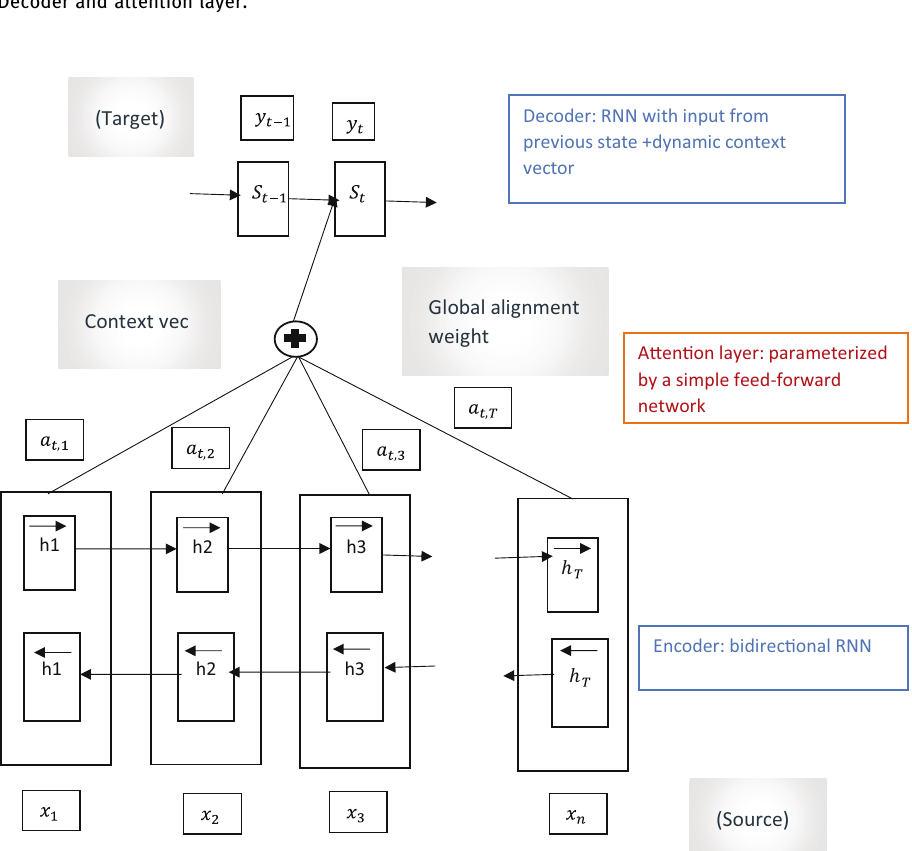
Figure 11: Additive attention